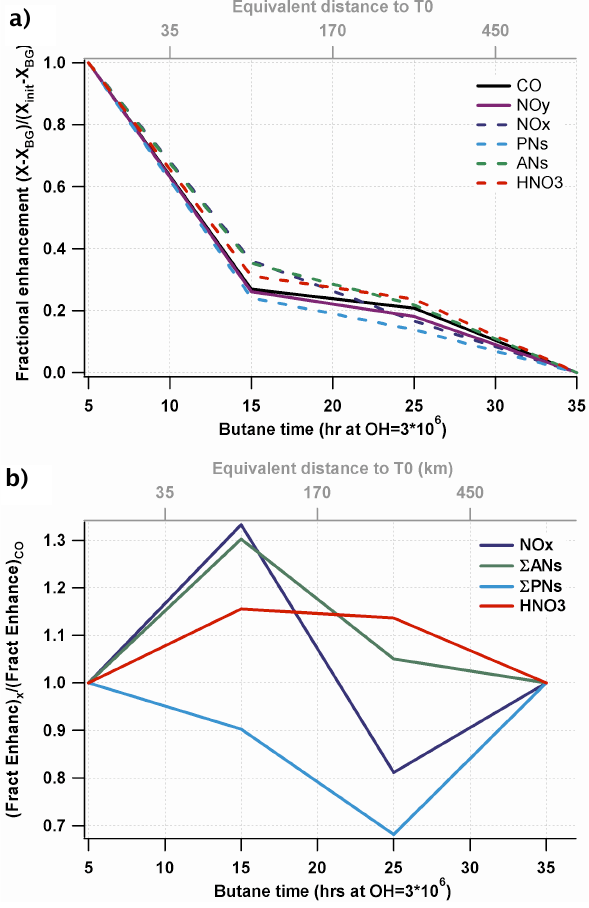
Fig. 5. (a) Fractional enhancement of CO (black solid), NO y (pur- ple solid), NO x (dotted dark blue), 6 PNs (dotted cyan), 6 ANs (dotted green) and HNO 3 (dotted red) used to assess possible im- pacts of deposition. Background levels are assumed to be equal to levels observed at the most aged point. The overall change is the change from the least aged to most aged points. See text for more description. (b) Dilution of the various NO y reservoirs relative to CO defined as (Fractional enhancement of X)/(Fractional enhance- ment of CO). NO x is shown in dark blue, 6 PNs in light blue, 6 ANs in green and HNO 3 in red.